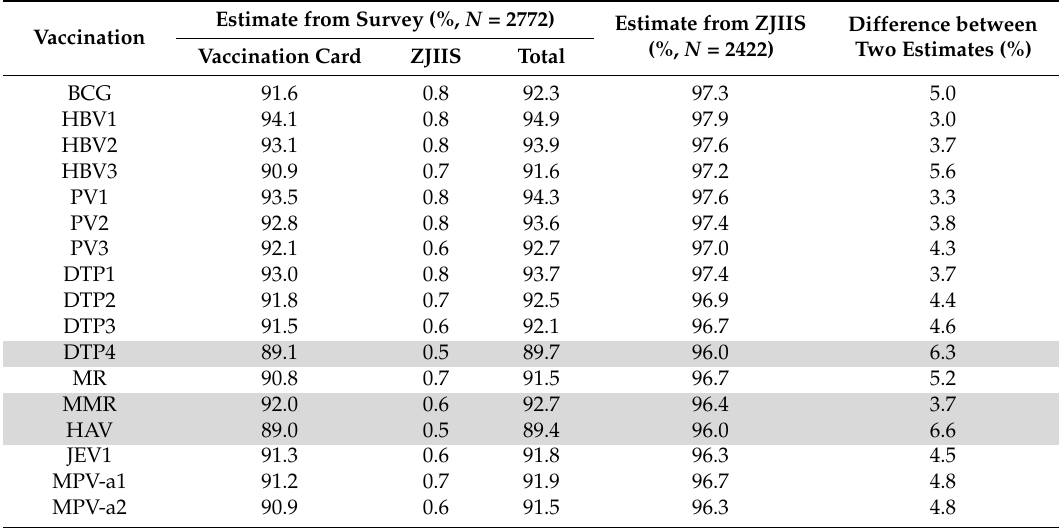
Table 3. Estimated vaccination coverage among children aged 24–35 months of age in Zhejiang province, based on the 2014 coverage survey and